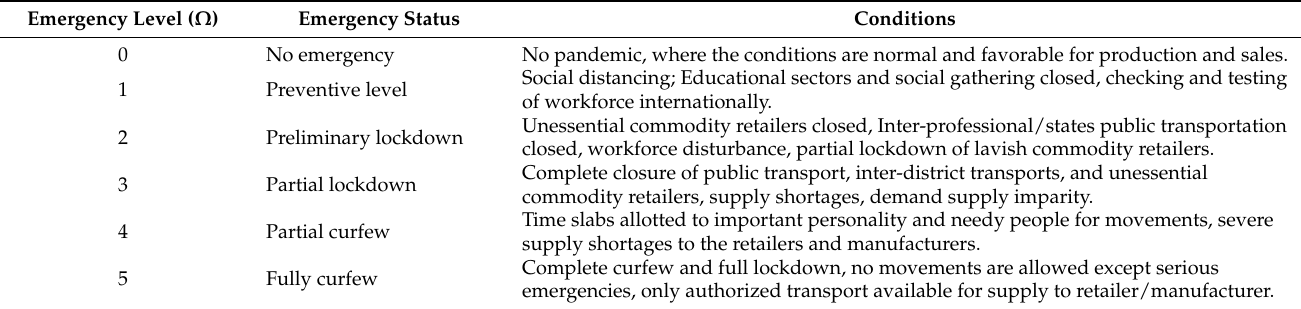
Table 2. The emergency levels with status and real-life conditions from 0 to